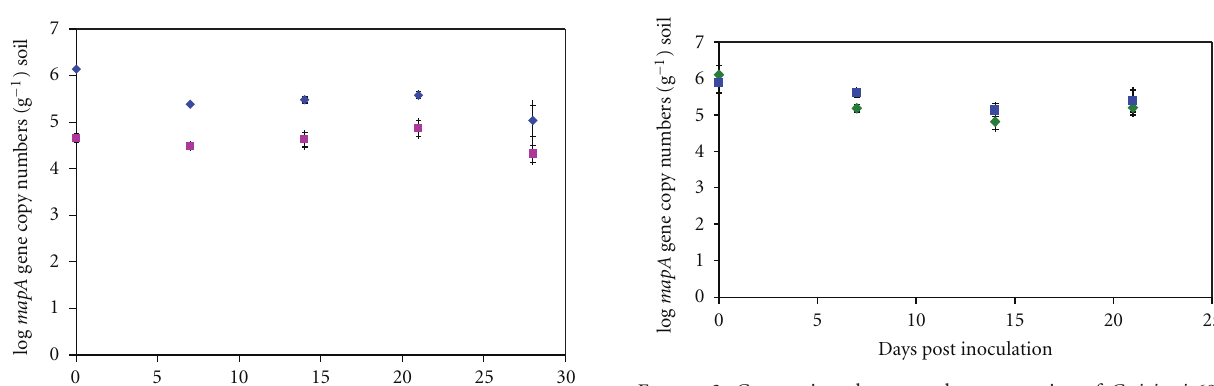
Figure 3: Comparison between the two strains of C. jejuni 6824 (green diamonds) and 81116 (blue squares) mapA gene copy numbers detected in soil in experiment B. Error bars represent standard deviations from 5 replicate samples and 3 di ff erent real- time PCR reactions per replicate.